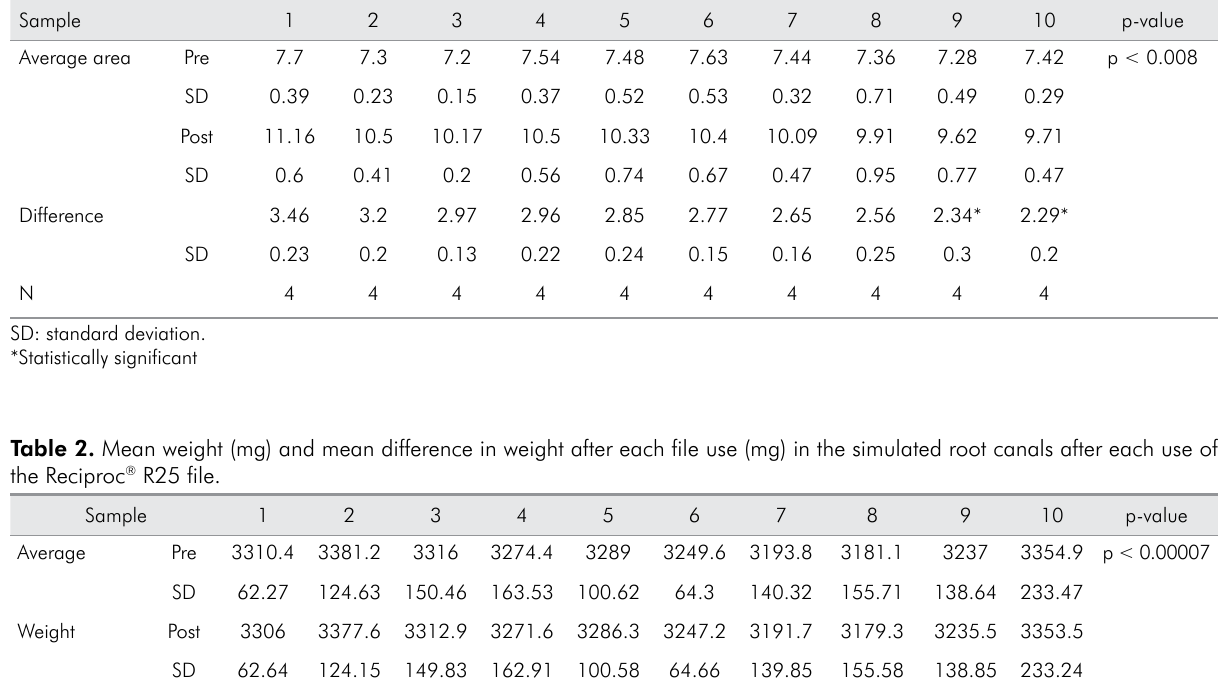
Table 1. Average area (mm 2 ) and widening (mm 2 ) of the simulated root canals after each use of the Reciproc ® R25 file. Sample